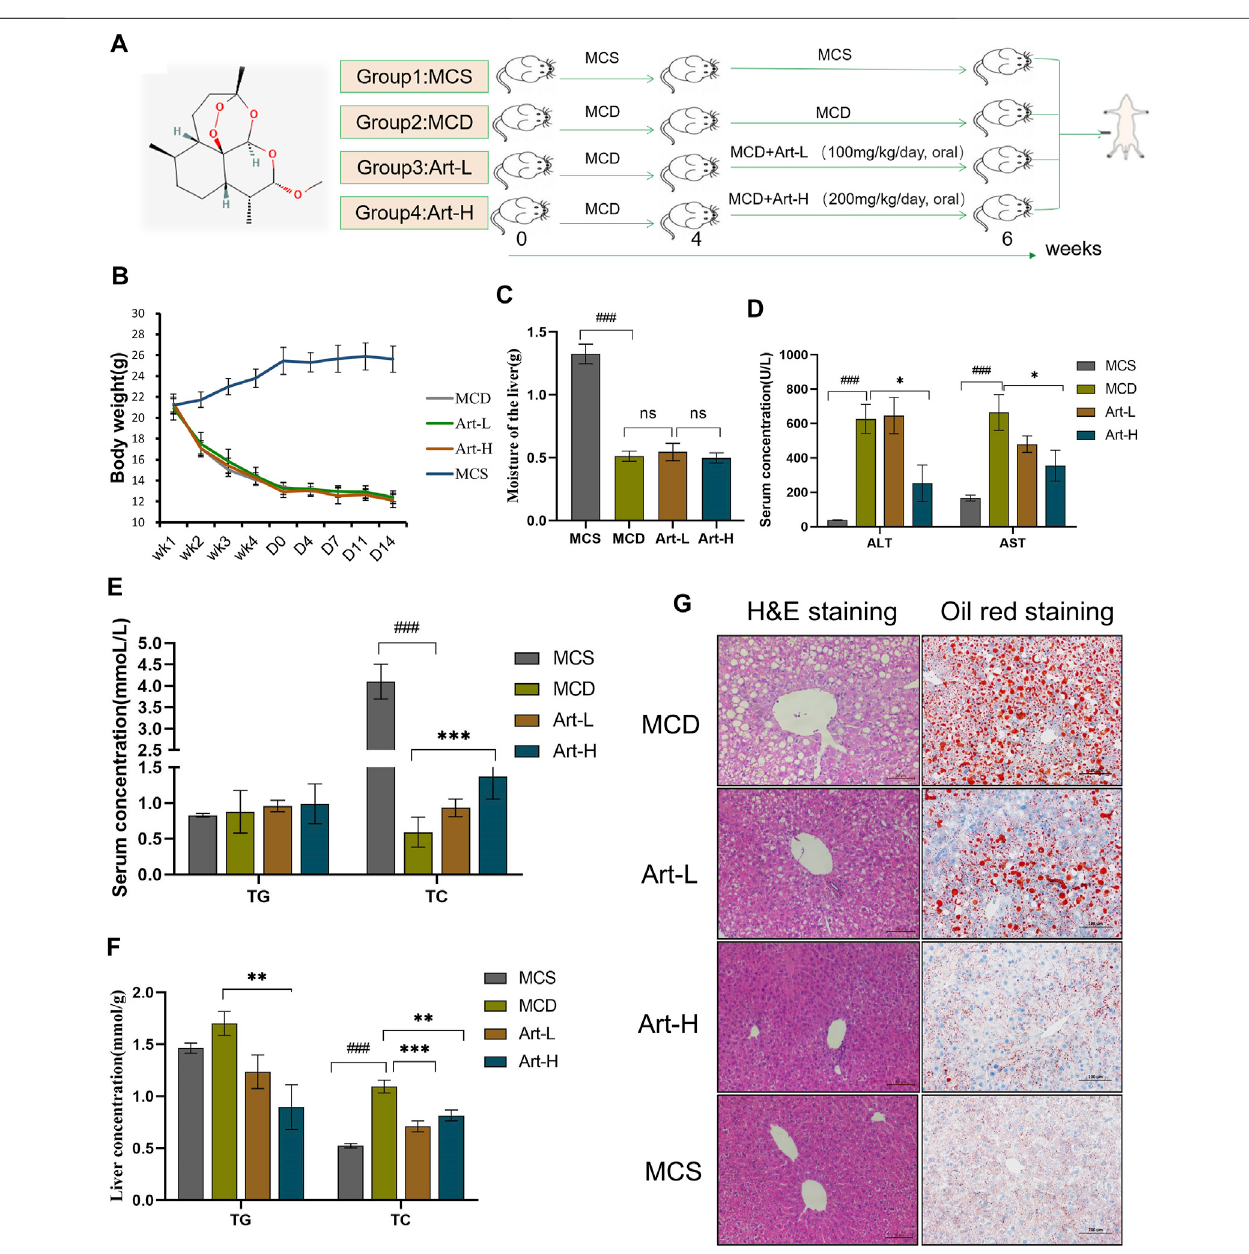
FIGURE 1 | Effect of Artemether treatment on hepatic injury and hepatic steatosis in the MCD model. (A) Experimental design: after 4 weeks of the MCD diet-inducedNASHmodel,the experiment was divided intofourgroups: the MCDdietgroup (MCD);MCD dietcoupledwithlow-doseartemether(Art-L) group:100 mg/kg BW;MCDdietcoupledwithhigh-doseartemether(Art-H)group:200 mg/kgBW,artemethergavageoncedailyfor2 weeks;andMCScontrolgroup(MCS)( n =6). (B) Body weight change after dosing in mice. (C) Mouse liver weight. (D) Serum ALT and AST levels in mice. (E) Serum TG and TC concentrations in mice. (F) TG and TC concentrationsintheliver. (G) Fromlefttoright,H&Estainingoftheliver(scalebar:50 μ M)and oilred Ostainingoftheliver(scalebar:50 μ M). TheMCSwascomparedwith the MCD group: # p < 0.05, ## p < 0.01, and ### p < 0.001. MCD compared with Art-L and Art-H groups: * p < 0.05, ** p < 0.01, and *** p < 0.001.